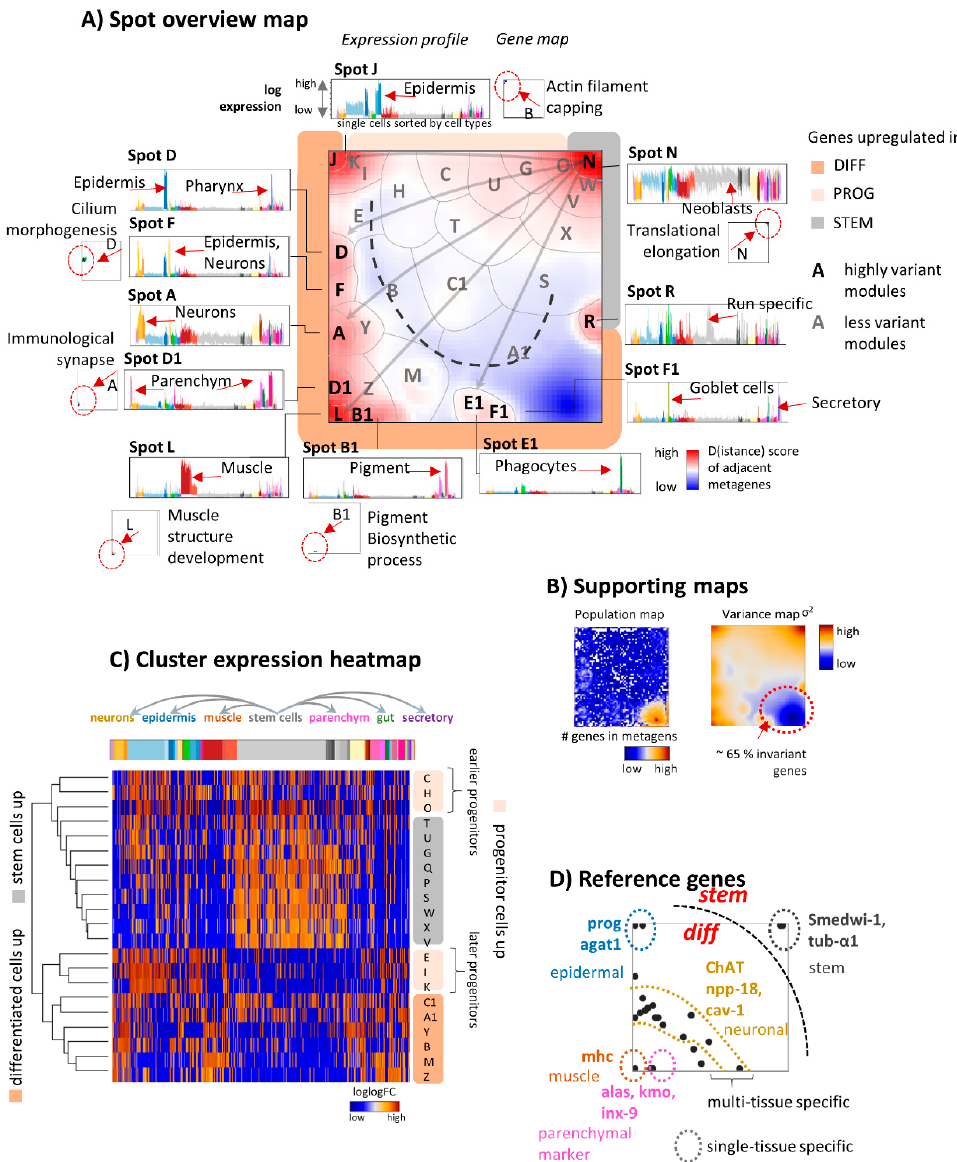
Figure 3. The single-cell transcriptomic landscape of the planarian Schmidtea mediterranea: ( A ) The module overexpression map provides an overview about modules of co-expressed and highly variant genes. They mainly arrange along the edges of the SOM and are labeled with bold capital letters A, D, F, J, L, N, R, B1, D1, E1, F1. The grey arrows illustrate selected developmental paths by linking the stemness spot N with the respective “tissue” spots. Expression profiles (gene set enrichment Z-score, GSZ-scale) and gene maps of selected functional gene sets underpin the functional context of these modules. They reveal specific up- and downregulation of the gene sets in di ff erent tissues (red arrows). The gene maps indicate the location of the genes by dots. Accumulation of genes in and near module areas are indicated by red arrows and dashed ellipses. ( B ) Population and variance maps visualize the number of genes in each metagene (log-scale) and the variance of metagene expression, respectively. About 65% of all genes studied show virtually invariant expression. They accumulate in the blue area in the right lower corner as indicated. ( C ) Expression profiles of the modules of low variant expression (labelled with non-bold letters in part A) are shown as heatmap. The arrows above the heatmap point in the direction of di ff erentiation from stem cells into di ff erent tissues. The spot modules group roughly into three clusters as indicated in the right part of the heatmap and along the edges of the SOM in part A. ( D ) Location of key reference genes are shown by dots (see also Figure S2 and Table S1). They are mostly found in or near the spots which upregulate in the respective